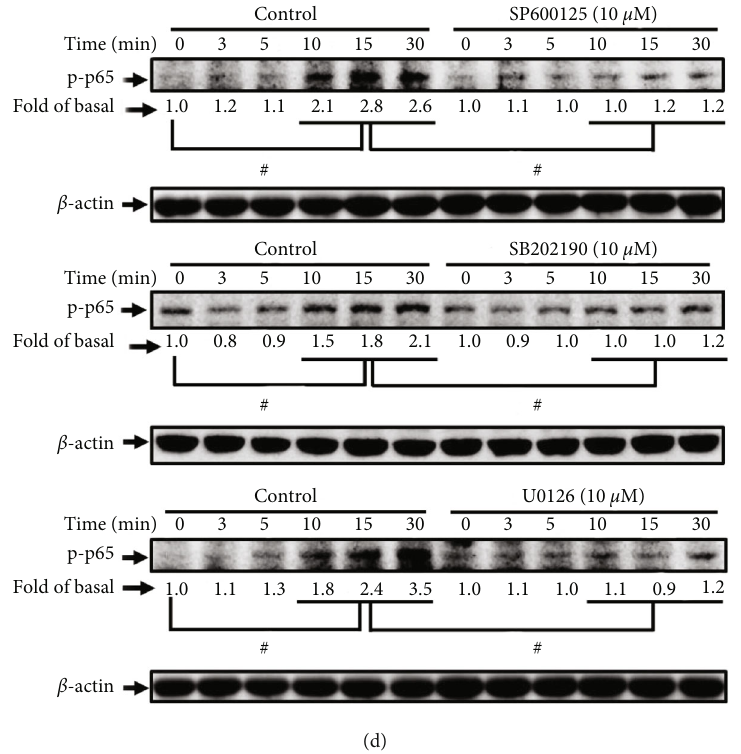
Figure 6: Thrombin induces NF- κ B activation via PKC α /MAPKs. (a) Cells were pretreated with helenalin (3 μ M), U0126 (10 μ M), SB202190 (10 μ M), or SP600125 (10 μ M) for 1h and then incubated with thrombin for 30 min. Cells were fi xed and then labeled with an anti-phospho-p65 antibody and then FITC-conjugated secondary antibody. Individual cells were imaged. Scale bar: 50 μ m. (b) Cells were pretreated with Gö6976 (3 μ M), U0126 (10 μ M), SB202190 (10 μ M), or SP600125 (10 μ M) for 1 h and then incubated with thrombin for 4h. The promoter activity of NF- κ B was determined. (c) Cells were pretreated with Gö6976 (3 μ M), U0126 (10 μ M), SB202190 (10 μ M), or SP600125 (10 μ M) for 1h and then incubated with thrombin for 30min. The NF- κ B p65 binding activities were analyzed by a ChIP assay. (d) Cells were pretreated without or with SP600125 (10 μ M), SB202190 (10 μ M), or U0126 (10 μ M) for 1h, and then incubated with thrombin for the indicated time intervals. The levels of phospho-p65 were determined by Western blot. Data are expressed as mean ± S : E : M : of three independent experiments. # P < 0 : 05 , as compared with the control or pretreatment with inhibitor indicated in the fi